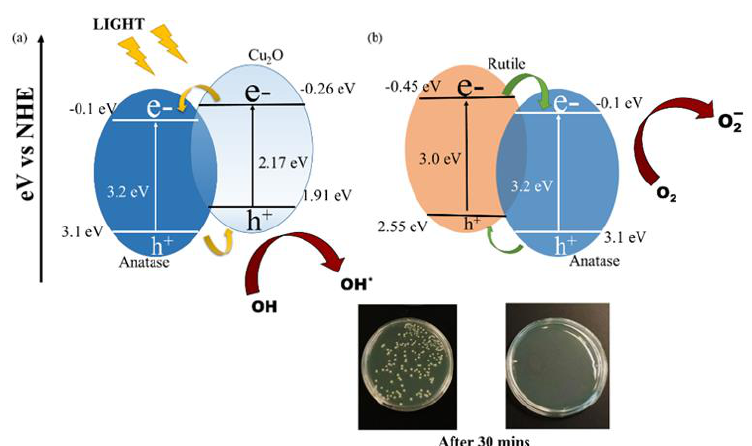
Figure 6. Mechanisms of photocatalytic antibacterial activity ( a ) p-n junction by heterostructured Cu 2 O and TiO 2 ( b ) Type-2 heterostructures of anatase and rutile TiO 2 nanoparticles. Images of S. aureus colonies in the agar plates with (right) and without (left) Cu-TiO 2 nanomaterials after 30 min illumination. Reproduced with permission from ref. [84]. Copyright © 2018, MDPI.